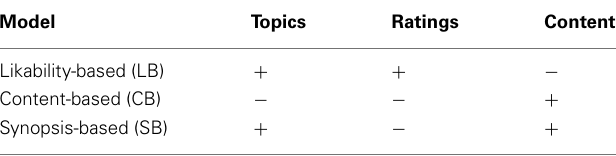
Table 10 | Summary of hypotheses in studies 2–5.